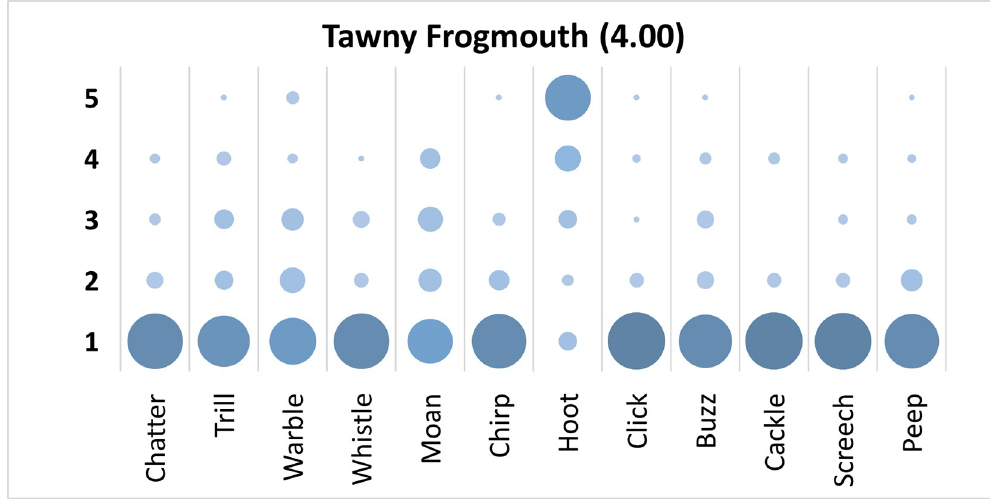
Fig 3. Count of participants’ sound descriptions scores for the Tawny Frogmouth with confidence ratings in brackets.